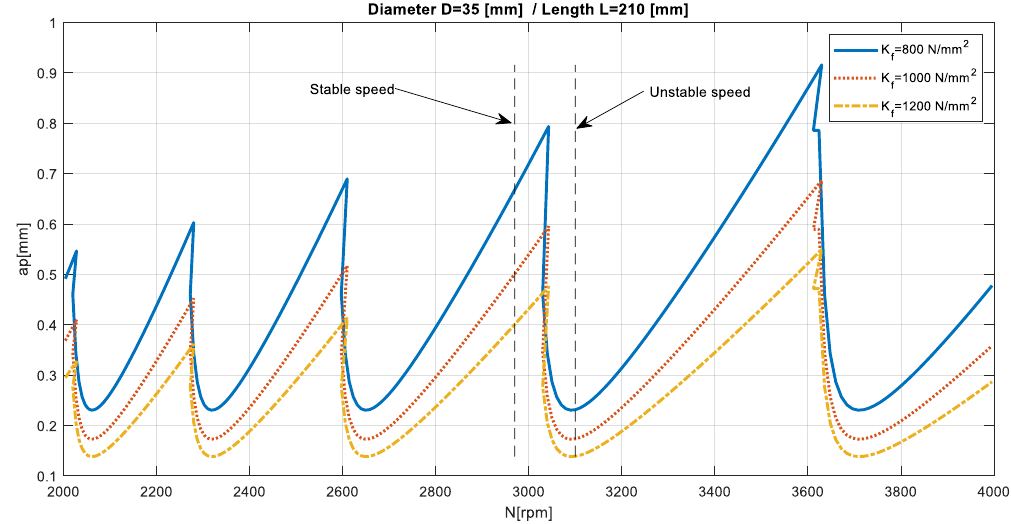
Figure 8. Stability lobes calculated for the machine–tool–workpiece system.